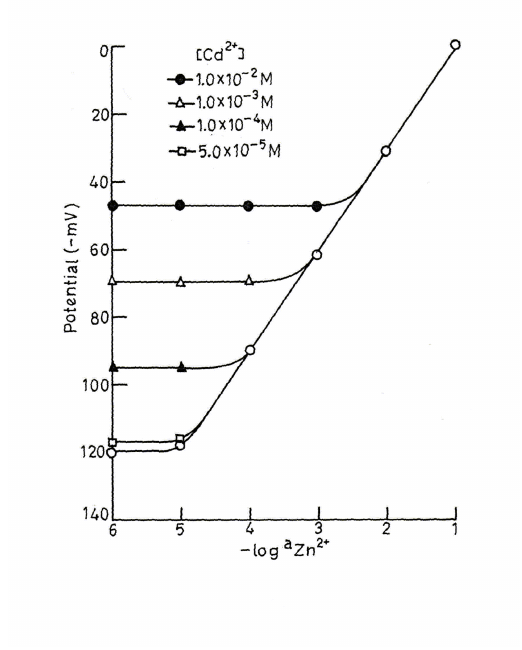
Fig.5 : Variation of potential with Zn 2+ concentration in presence of different concentration of Cd 2+ .